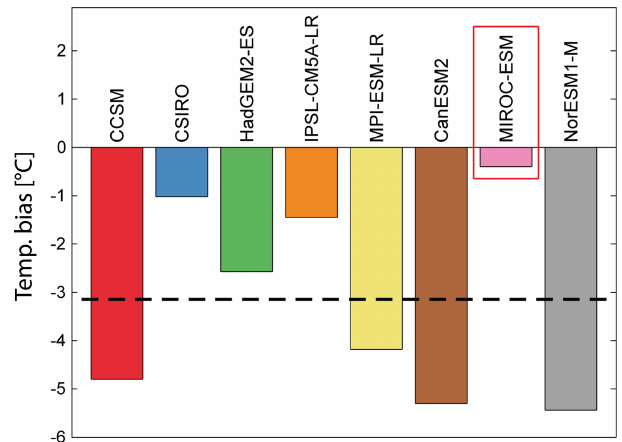
Figure A1. Near-surface temperature bias for the baseline period 1980–2005 in GCMs for RCP4.5 projections in relation to ERA- Interim. Dashed black line indicates multi-model mean ( − 3 . 1 ± 2 . 0 ◦ C). The selected forcing is highlighted by the red box.